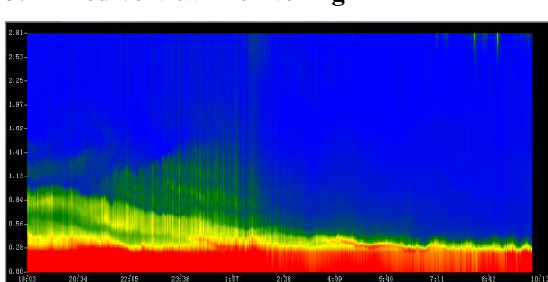
Fig.1 Vertical Monitoring and Analysis Chart of Backscatter Lidar of Hefei City from 11:00 on February 8, 2018 to 10:00 on February 9, 2018